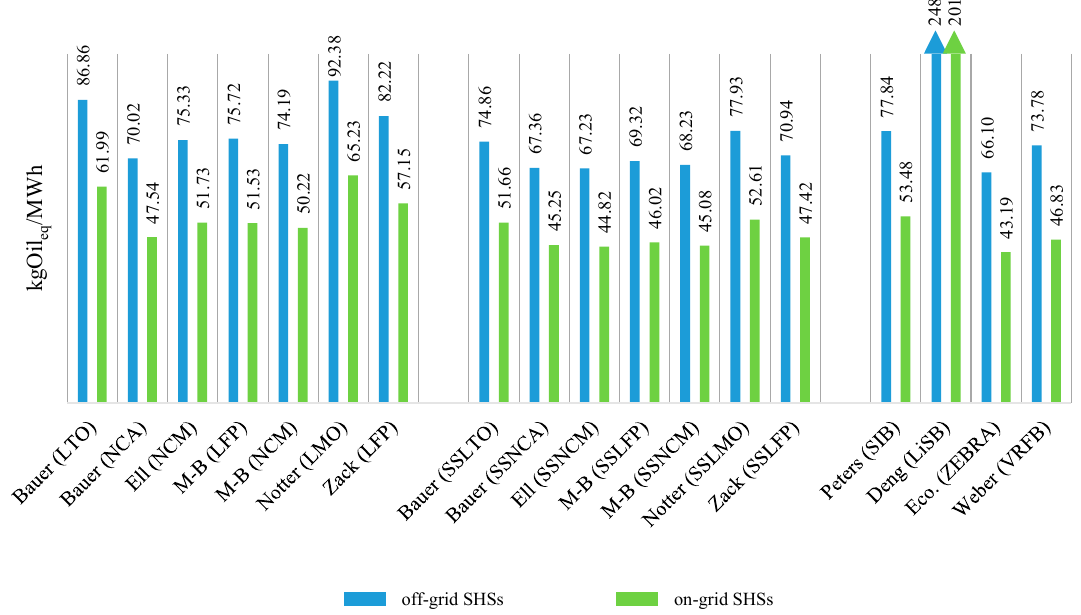
Figure 4. LCA impact values of SHSs in Italy for the fossil depletion indicator.